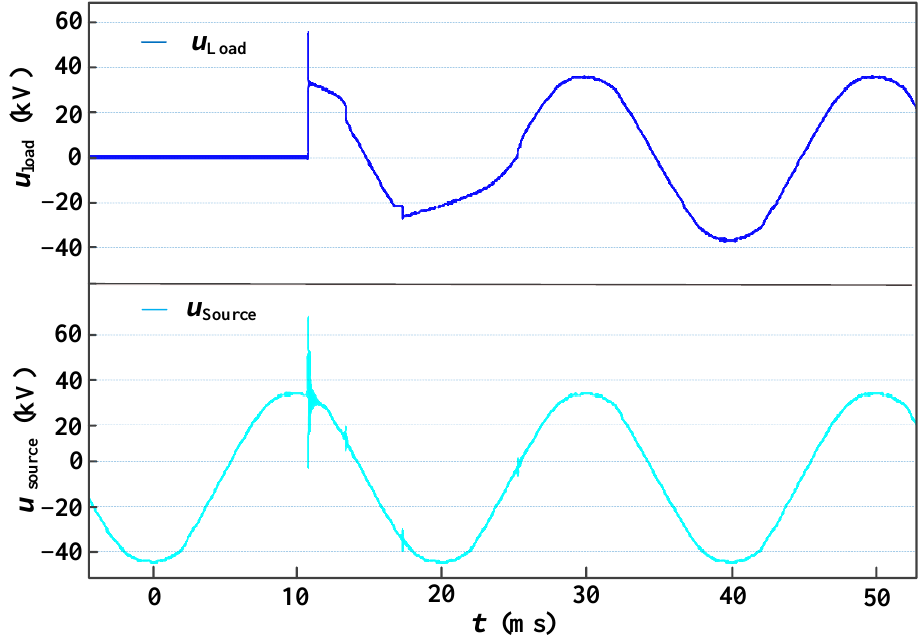
Figure 16. Operating overvoltage in the closing process of the vehicle-mounted circuit breaker. The circuit breaker has obvious overvoltage during operation. The overvoltage is larger near the peak value, and the overvoltage multiple is 2.0. Meanwhile, during closing at different phase angles, the overvoltage generated will be reduced (see Figure 17). When the closing angle is − 65°, the circuit breaker is closed, and the overvoltage multiple is 1.1.